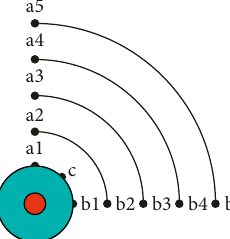
Figure 6: Measuring points arrangement.